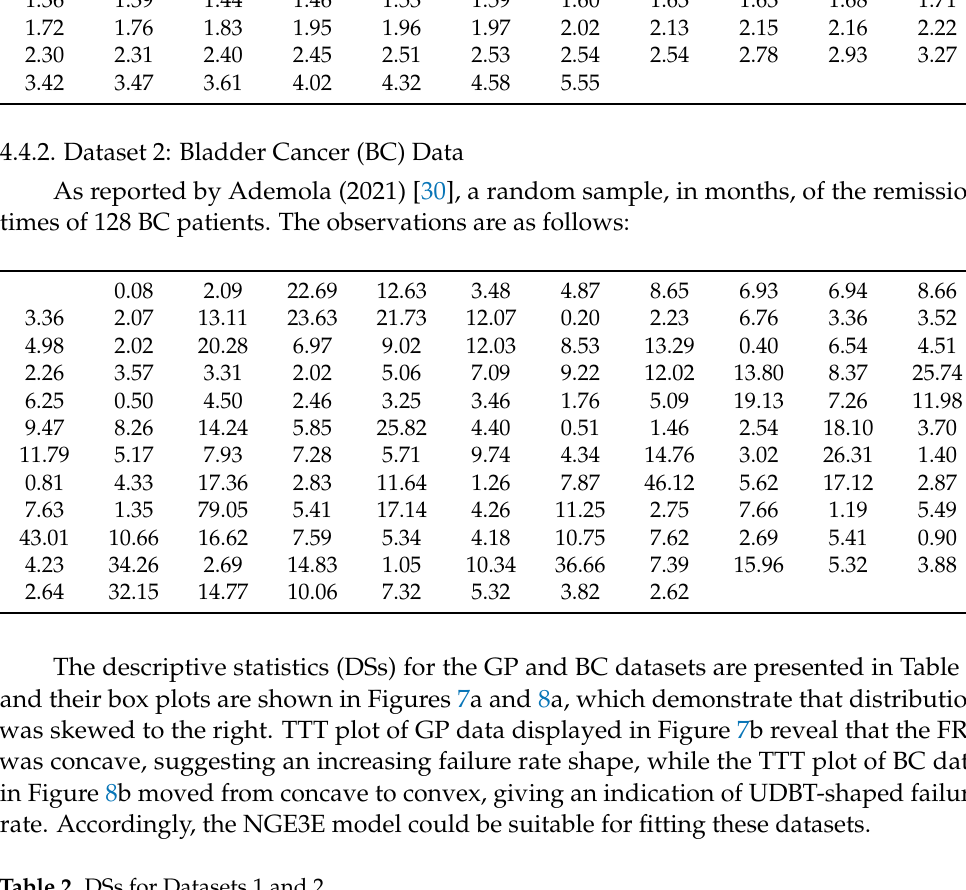
Table 2. DSs for Datasets 1 and